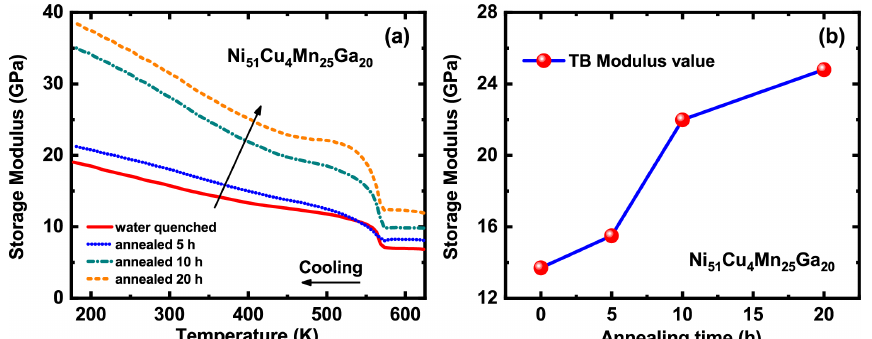
Figure 4. ( a ) Temperature dependence of storage modulus for the water quenched and annealed Ni 51 Cu 4 Mn 25 Ga 20 alloys measured at the frequency of 0.4 Hz. ( b ) Storage modulus value corresponding to twin boundary damping peak as a function of annealing